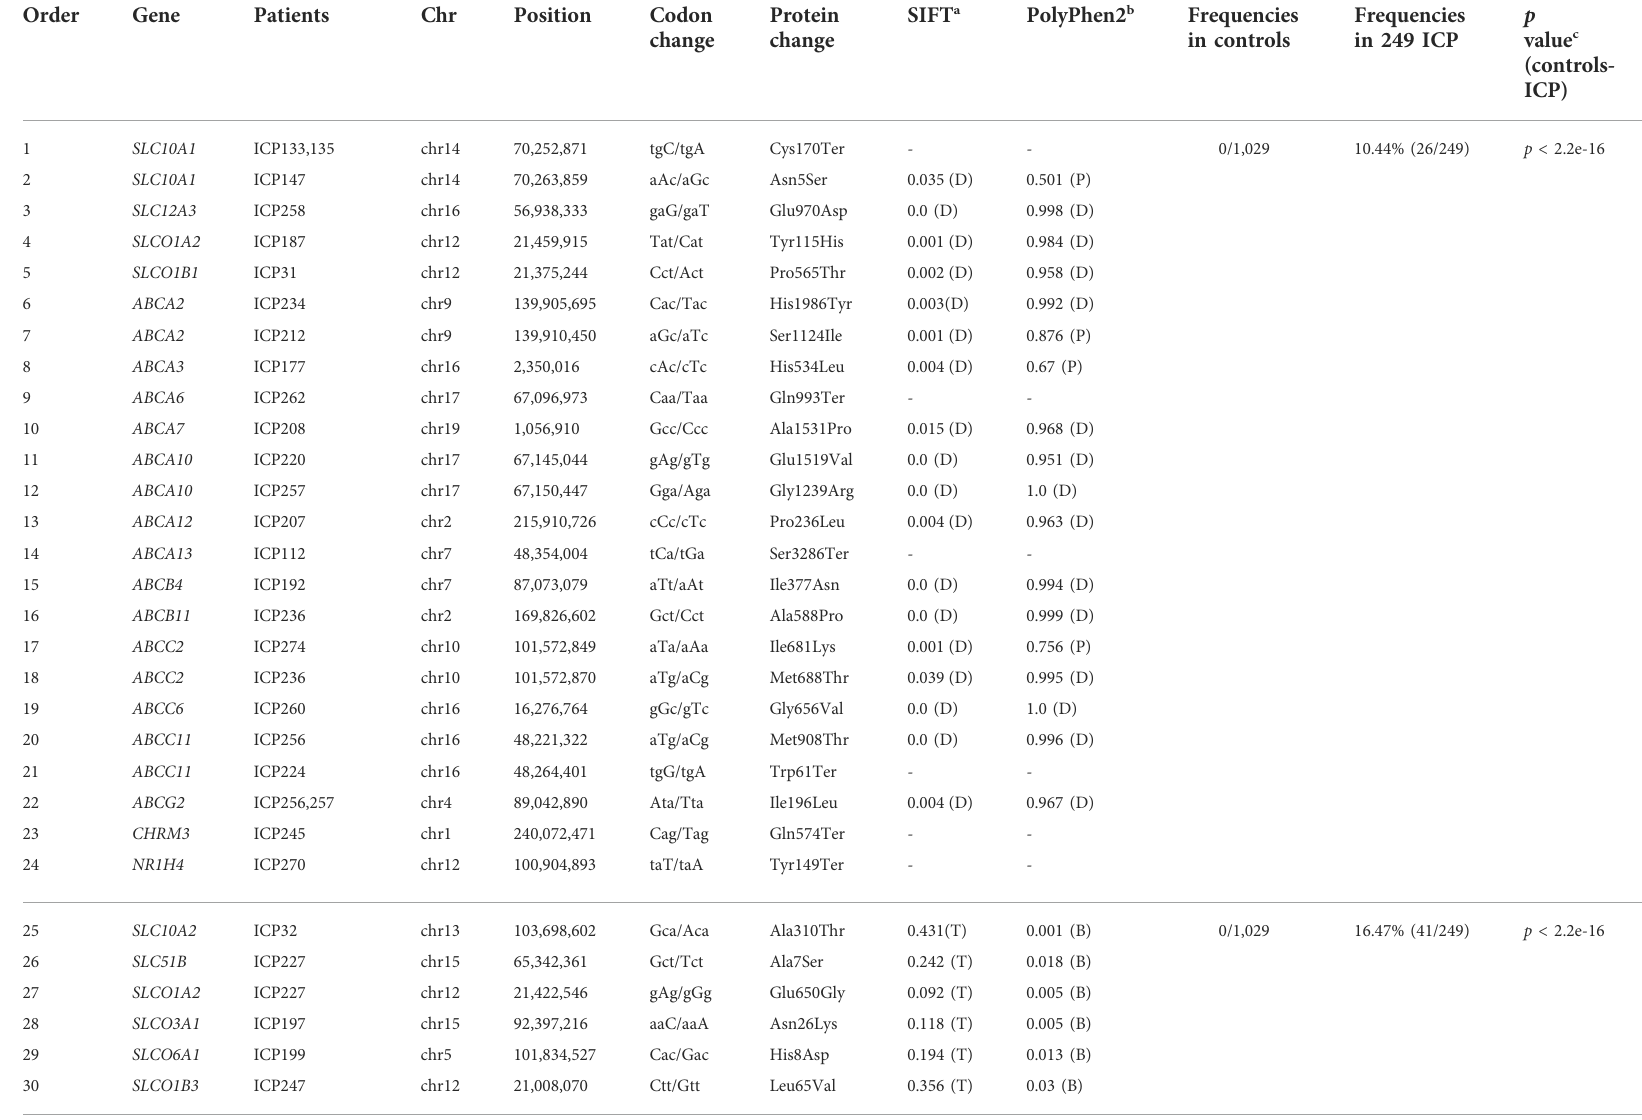
TABLE 2 Sixty-two novel mutations were identi fi ed in 249 Han Chinese patients with ICP disease.